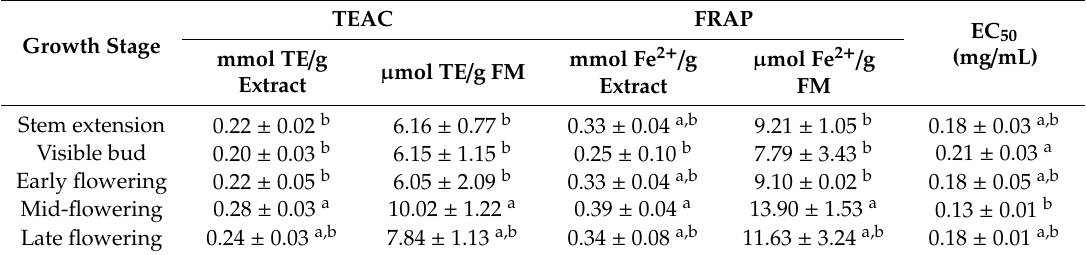
Table 5. Trolox equivalent antioxidant capacity (TEAC), ferric-reducing antioxidant power (FRAP) and DPPH • scavenging activity (expressed as EC 50 ) of the sunflower extract and fresh matter (FM) of plants at various growth